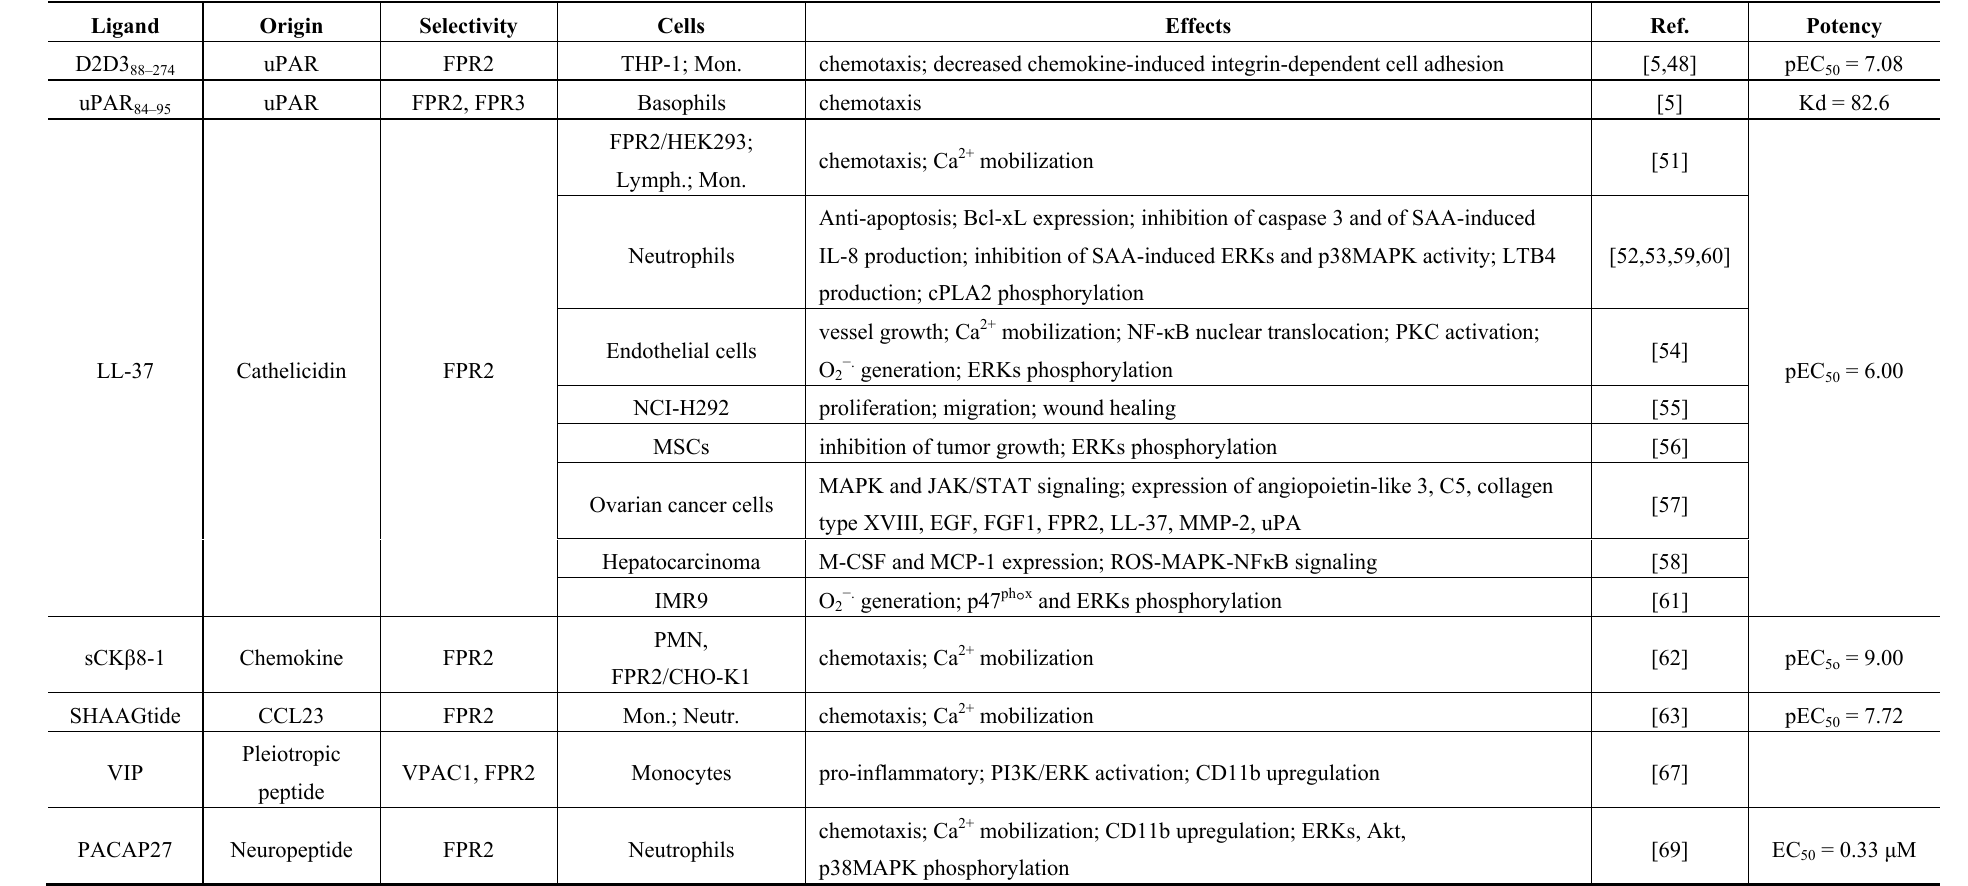
Table 4. Intracellular signaling cascades triggered by peptides associated with inflammatory and anti-inflammatory